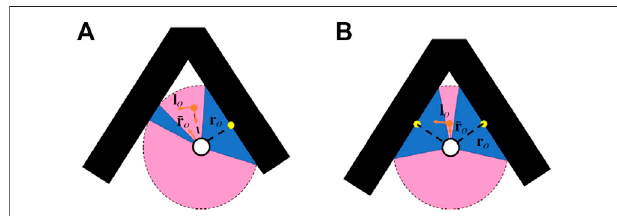
TABLE 1 | List of parameter values used in the